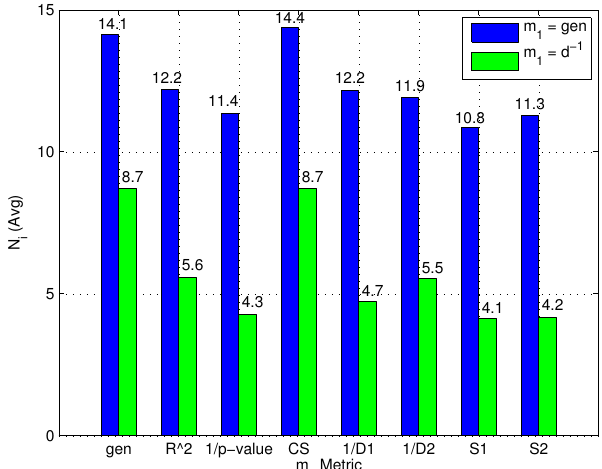
Figure 9. Impact of m